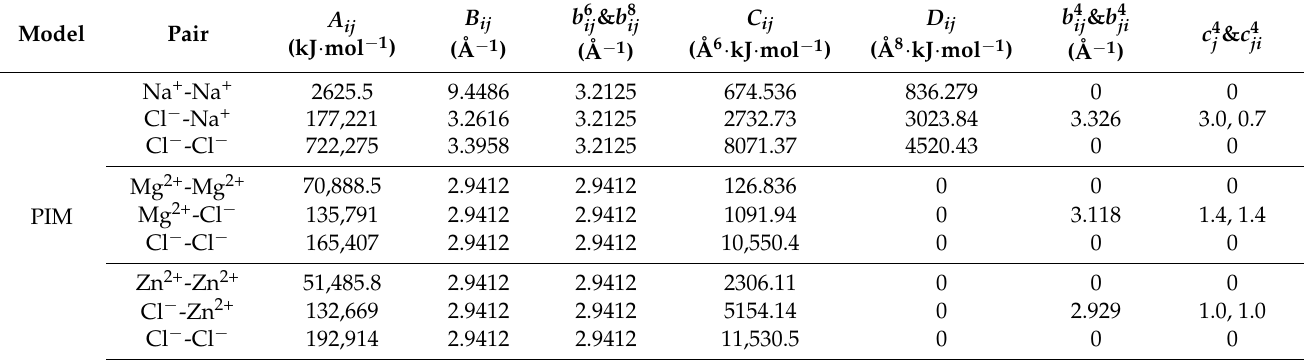
Table 2. Potential parameters of PIM for molten chloride salts.